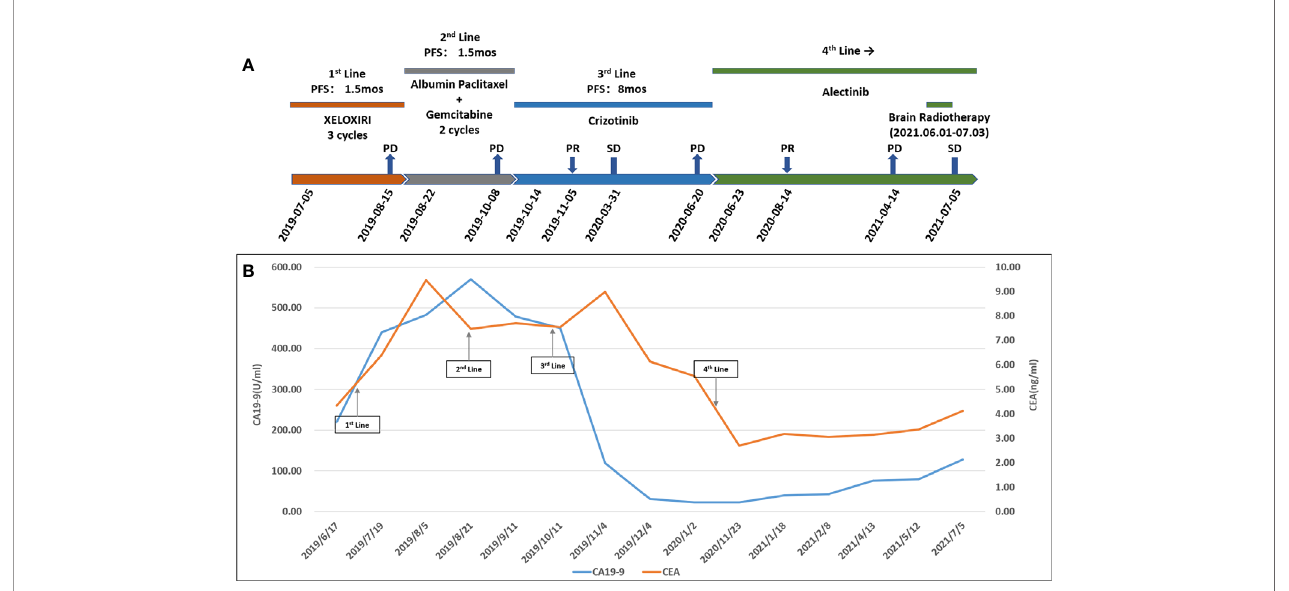
FIGURE 3 | (A) Treatment process. PFS, progression-free survival; XELOXIRI, irinotecan, oxaliplatin and capecitabine; PD, progressive disease; SD, stable disease; PR, partial response; mos, months. (B) Change in cancer antigen 19-9 (CA19-9) (U/ml) levels and carcinoembryonic antigen (CEA) (ng/ml) levels with